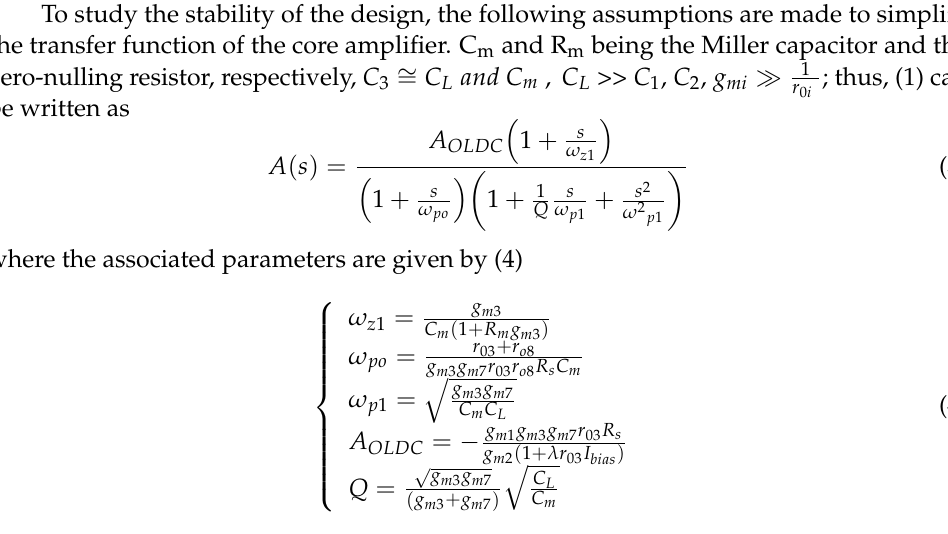
Figure 4. The small-signal model of the core Miller compensation with zero nulling resistors (MCNR)